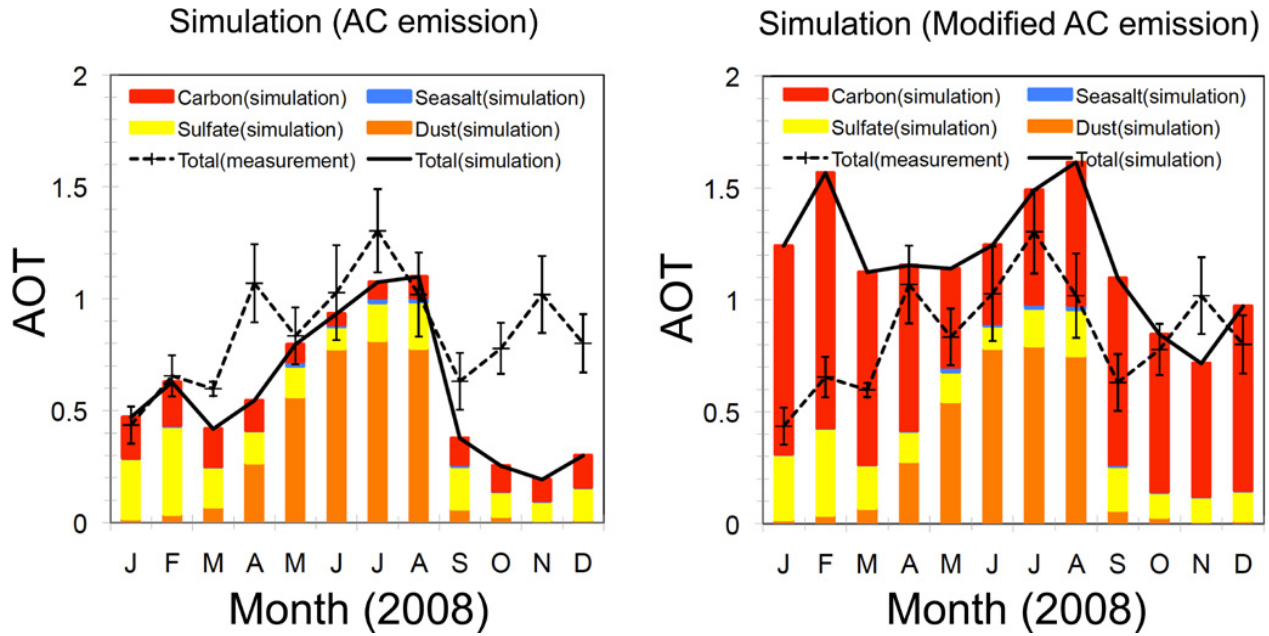
Fig. 4. Model simulation of mean monthly AOTs for the year 2008 with ranging atmospheric composition, i.e., dust with orange, sulfate with yellow, carbonaceous with red and sea salt with blue. The measurement values are shown in dashed